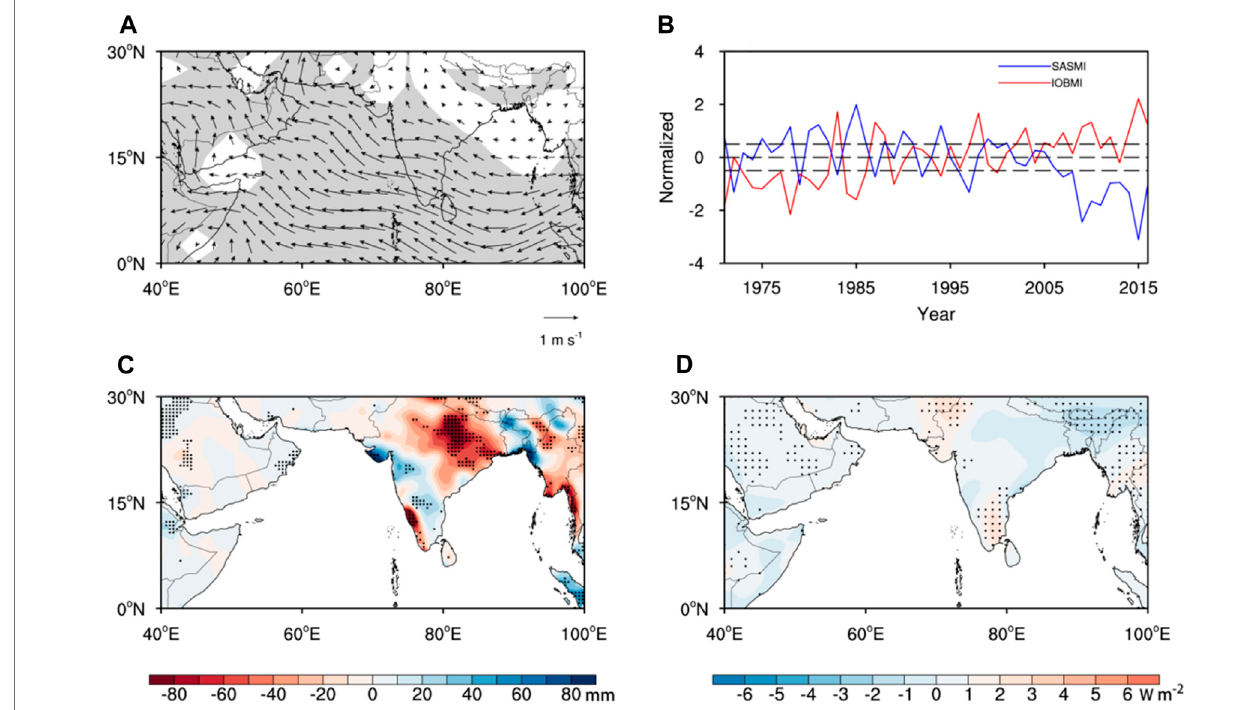
FIGURE8|(A) Regressionof850-hPawindagainsttheIOBMIduring1971 – 2016,shadedregionsshowsigni fi canceat α (cid:2) 0 . 05level. (B) TimeseriesoftheIOBMI and SASMI during 1971 – 2016. (C) as (A) , but for summer rainfall, (D) as (A) , but for surface latent